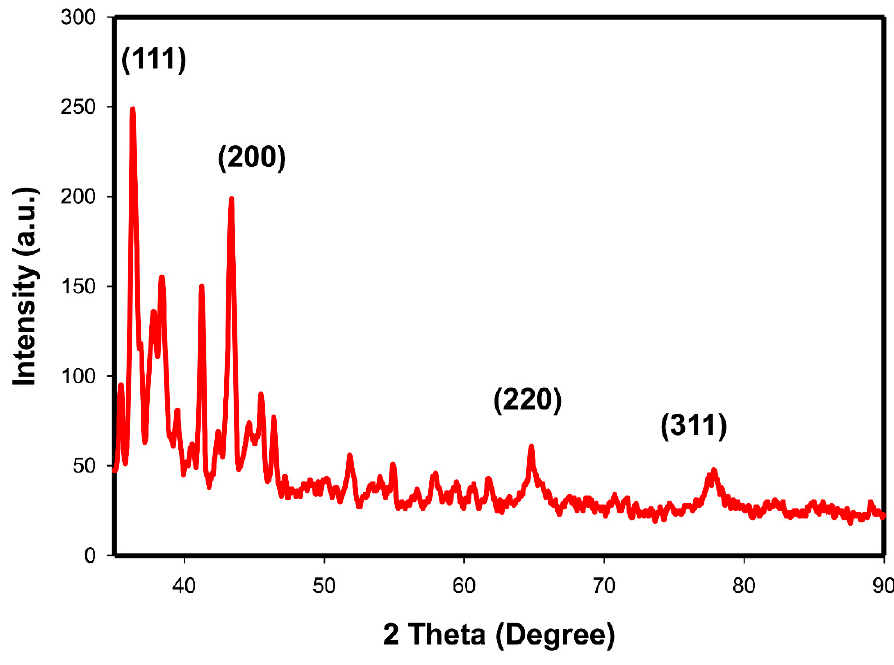
Figure 3. X-ray diffraction analysis of AuNPs.